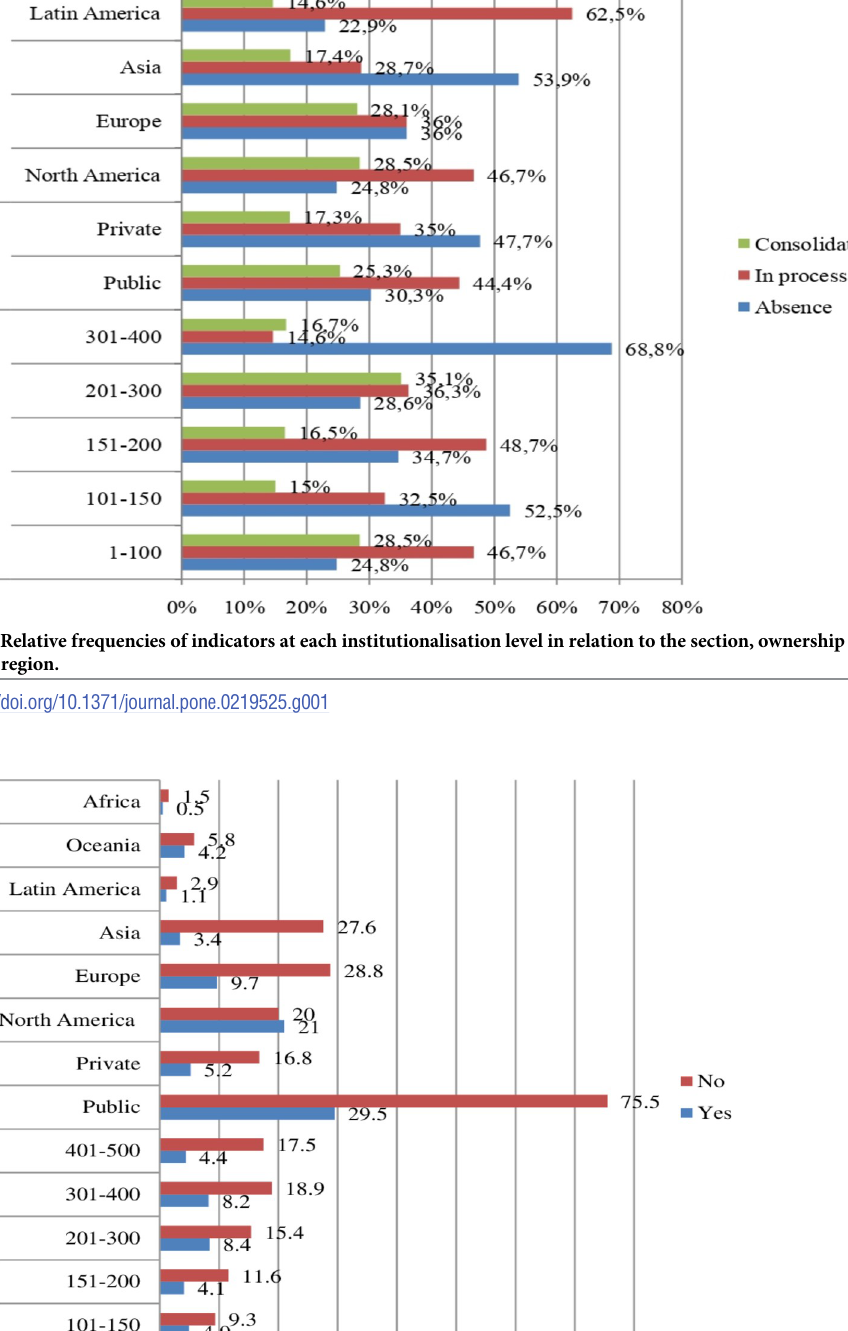
PLOS ONE | https://doi.org/10.1371/journal.pone.0219525 July 24,